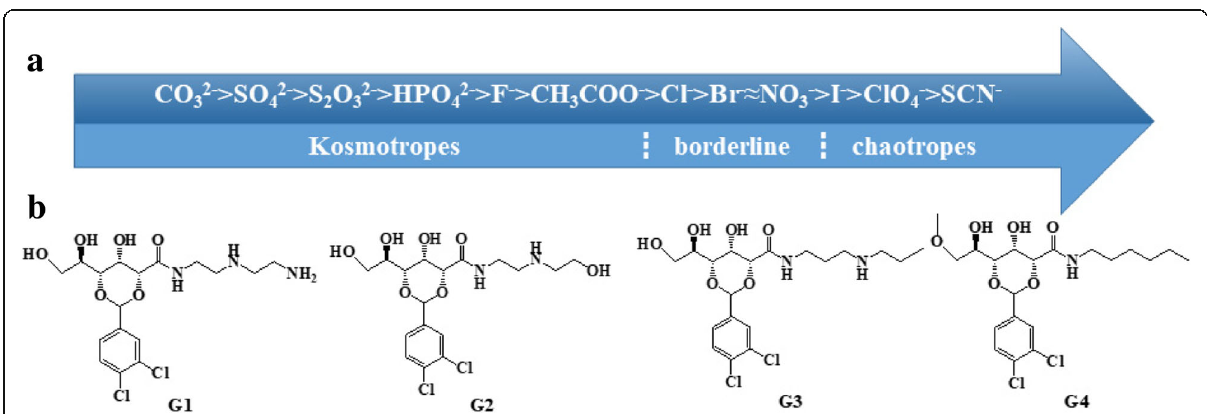
Fig. 1 a Hofmeister anions. b Chemical structures of gelator Gn ( n = 1 – 4)